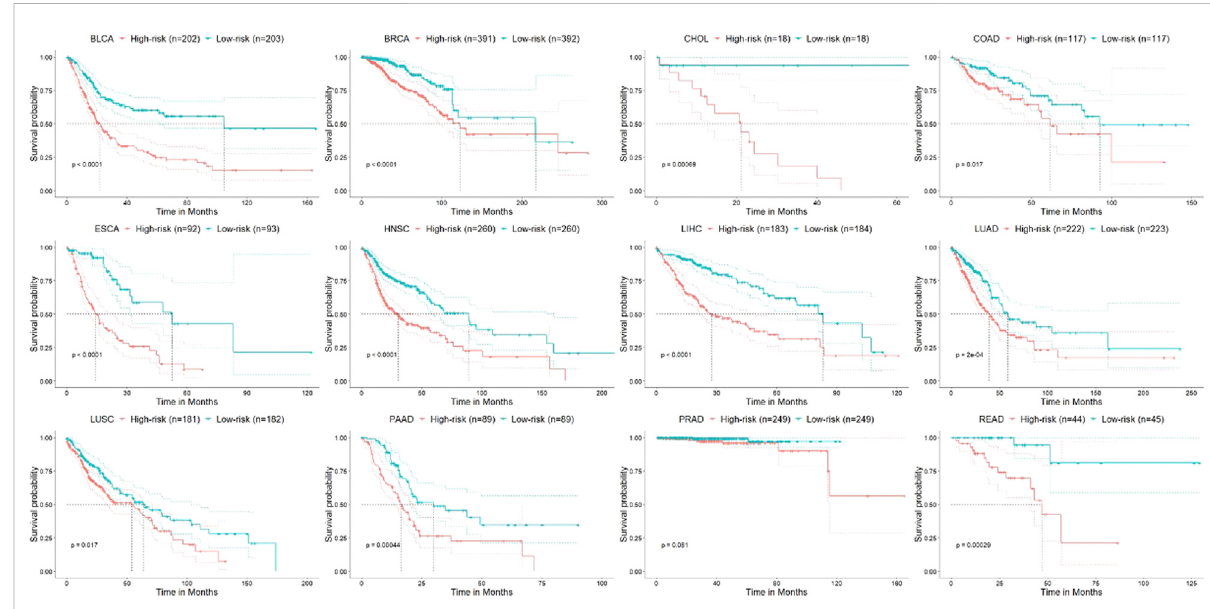
FIGURE 6 Kaplan – Meier survival curves for overall survival of different types of cancer. Statistical difference in the outcome between high and low PI groups is indicated by the log-rank test p- value. “ + ” stands for the censoring